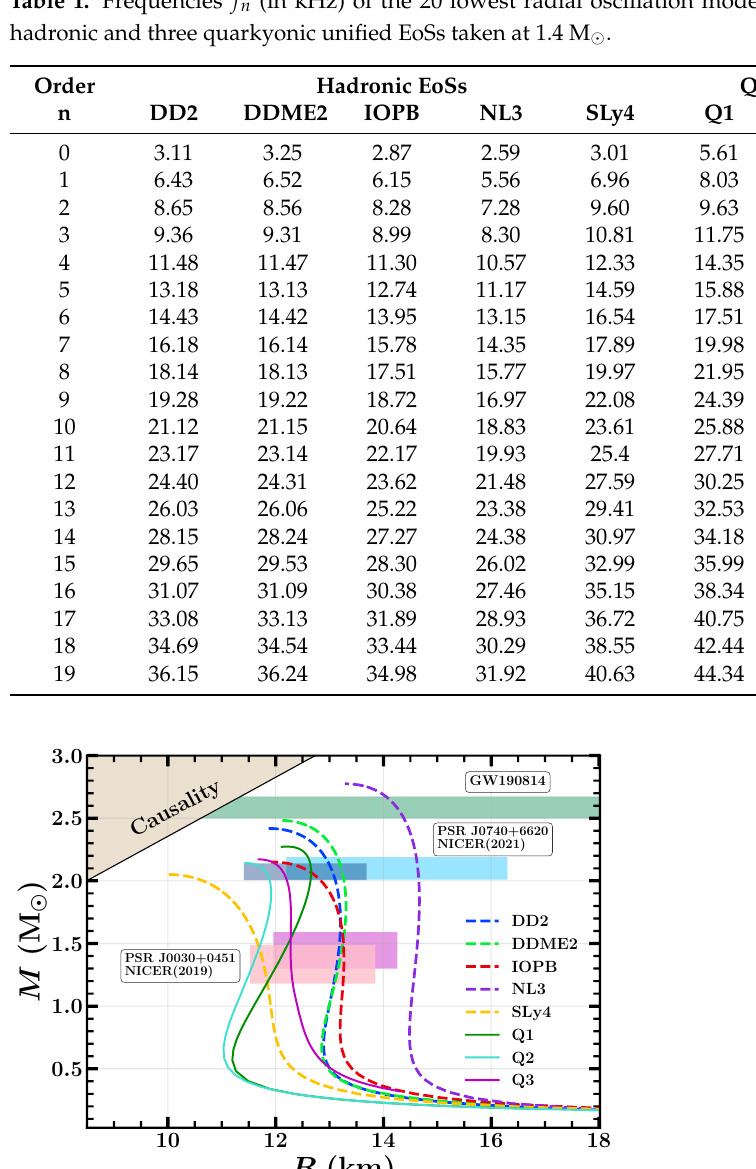
Figure 2. NS mass-radius relation for our choice of EoSs. The lower pink and magenta boxes show the constraints on the mass and radius from the 2019 NICER data of PSR J0030+0451 by Riley and Miller [53,54]. The upper dark and light blue boxes show the 2021 NICER data with X-ray Multi- Mirror observations of PSR J0740+6620 [55]. Observational mass data from merger event GW190814 is shown as a horizontal green band [56]. The upper left region is restricted so that the speed of sound in the object does not surpass the speed of light in vacuum